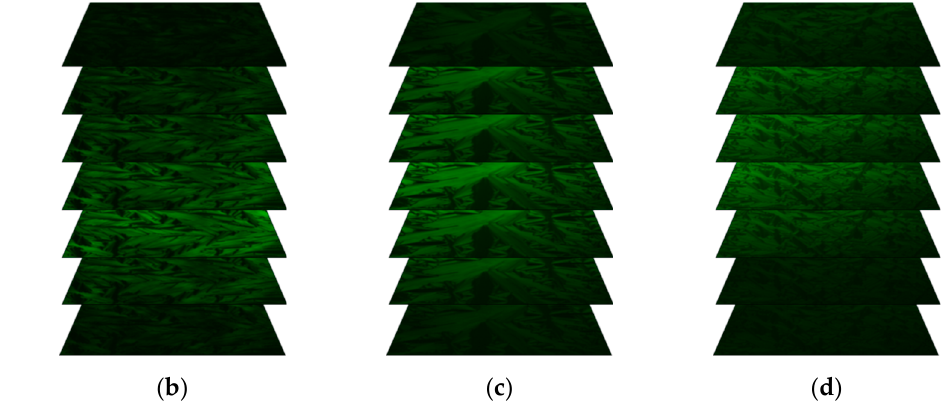
Figure 5. Fluorescence images in subsequent slices for the Au nanoparticles (at room temperature) ( a ), Composite 1 ( b ), Composite 2 ( c ), and Composite 3 ( d ) registered in the spectral ranges 490–590 nm. For Composites 1–3, the images were registered at 68 °C (SmC* A